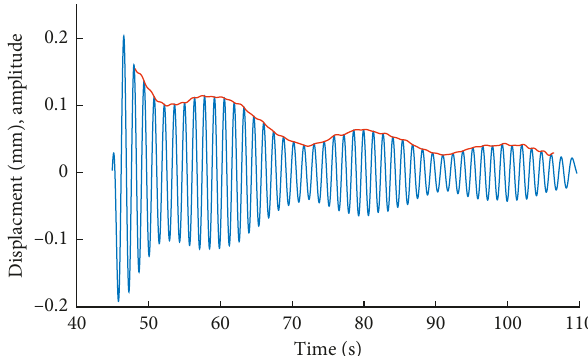
Figure 3: Hilbert transform calculated for signal obtained from damping vibrations with beat frequencies (reproduced from [24], under the Creative Commons Attribution-NonCommercial 4.0 International